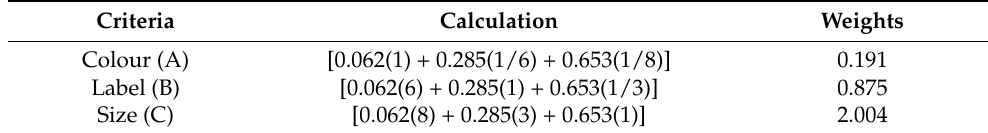
Table 13. The weights matrix—A3.